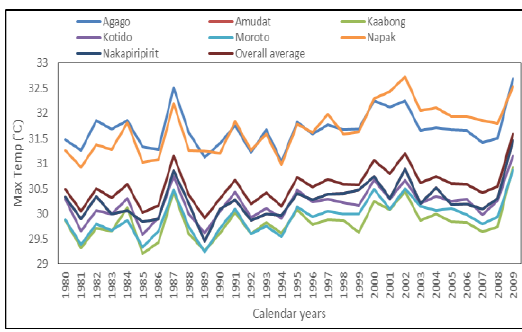
Figure 3. Historical minimum temperature for Karamoja sub-region.